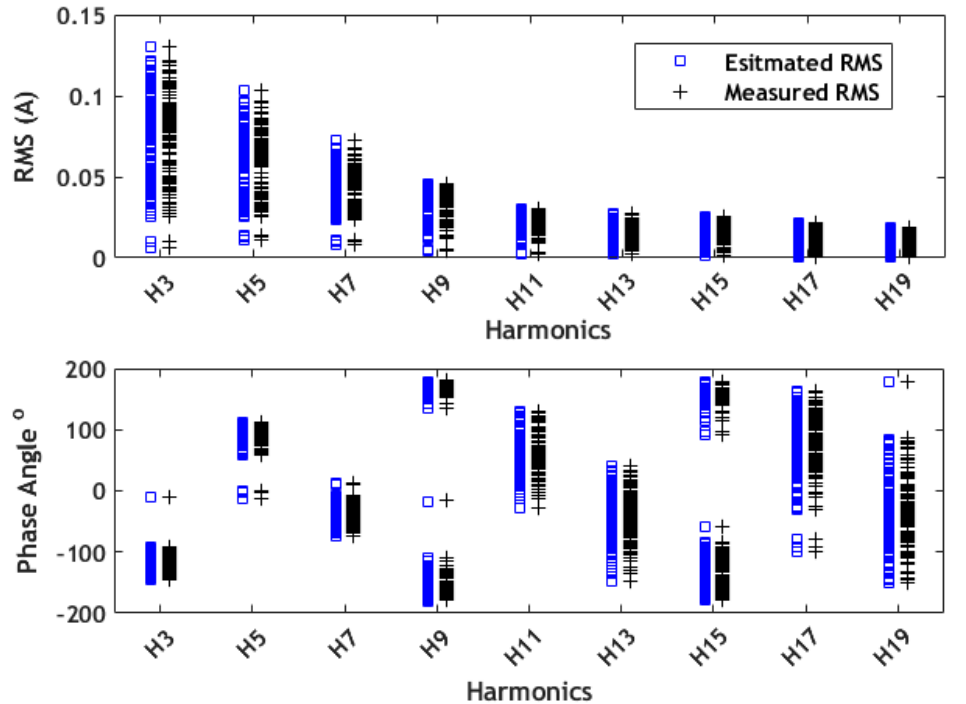
Figure 6. Harmonic RMS and phase values of all lamp combinations.